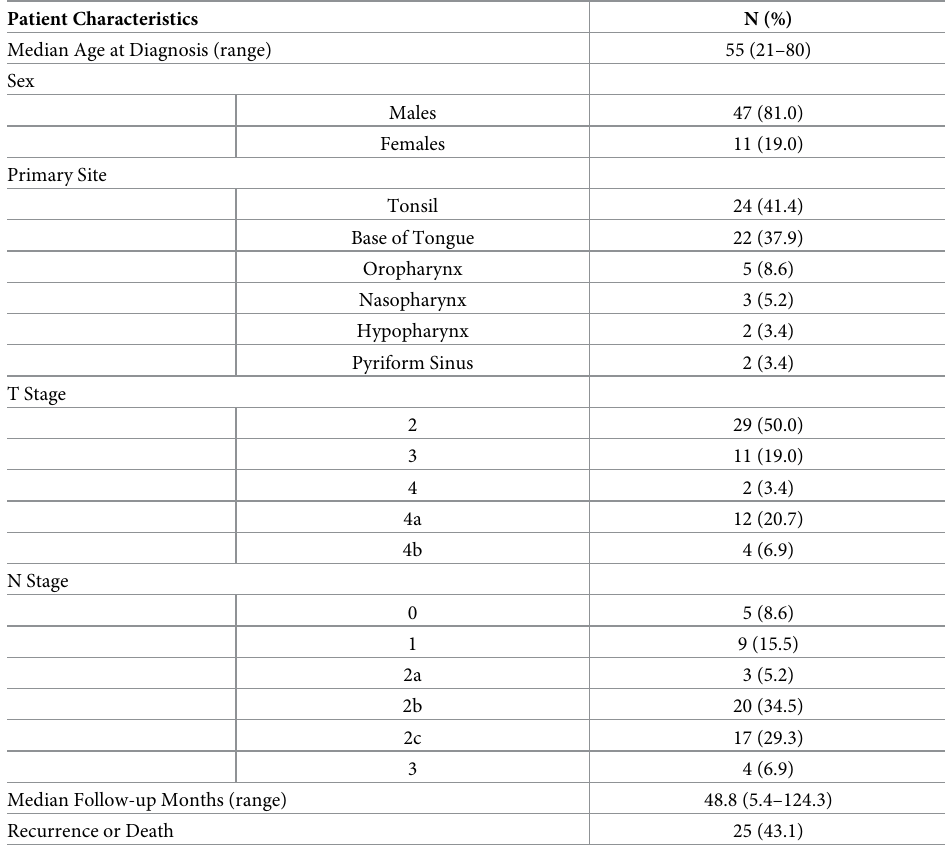
Table 1. Demographic and clinical characteristics. Patient